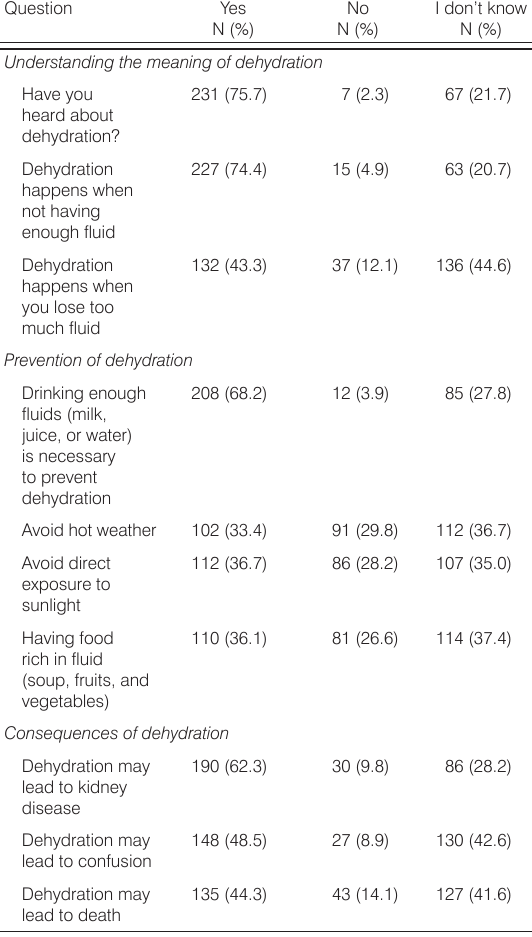
Table 2. Distribution of the study subjects regarding the dehydration knowledge of the elderly ( N =